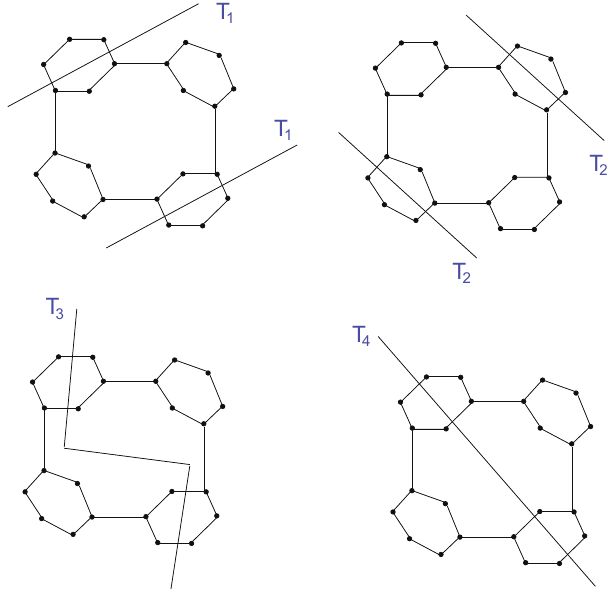
Figure 2: Quasi - orthogonal cuts of [ ] P m n ,